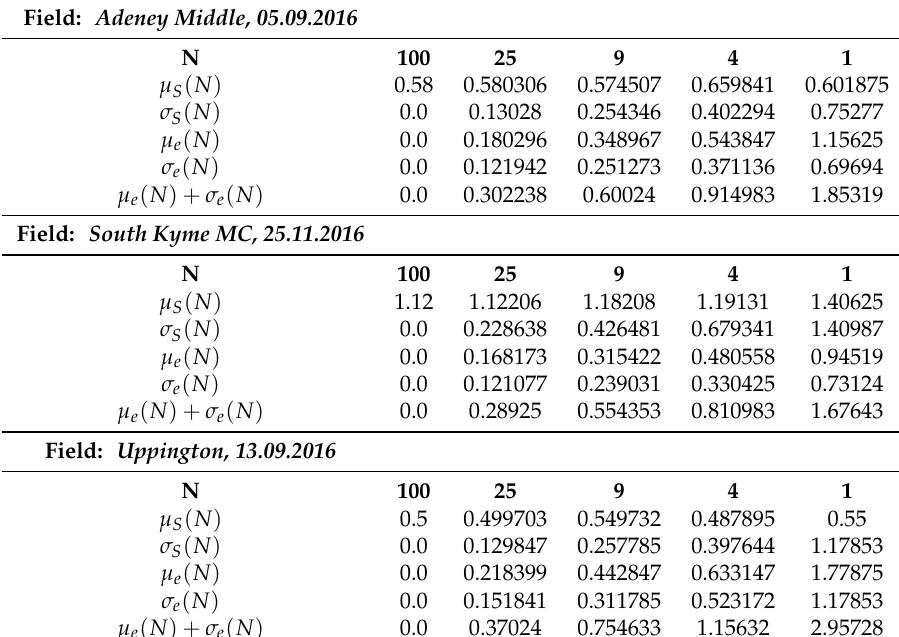
Table 2. Evaluation of the average trap count on coarse sampling grids. Analysis of the evaluation accuracy for the slug distribution from data taken in various agricultural fields (as shown in the table). The mean value µ S ( N ) and the standard deviation σ S ( N ) are computed for the average trap count S c on a sequence of quasi-regular grids with number N of sampling locations. For any realisation of the average trap count the error (2) is computed. Given K realisations of error (2), the mean evaluation error µ e ( N ) , the standard deviation σ e ( N ) of the evaluation error, and the upper error bound µ e ( N ) + σ e ( N ) are computed for each N in the